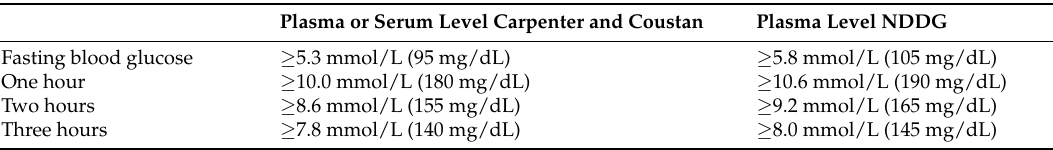
Table 1. ACOG diagnostic criteria for the 100-g OGTT to diagnose GDM (Step 2). Plasma or Serum Level Carpenter and